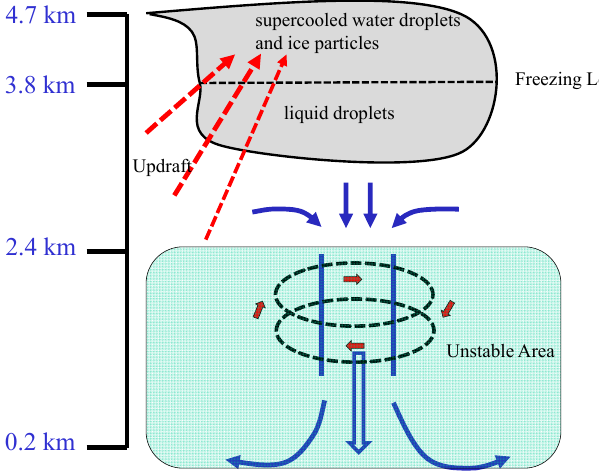
Figure 9. Schematic of the formation of the studied downburst.